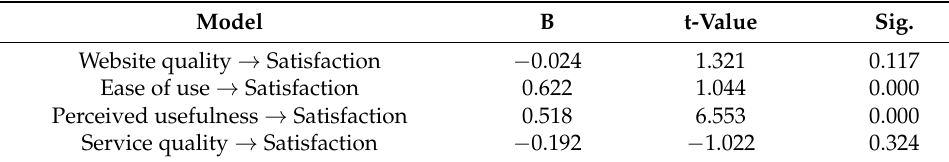
Table 6. Hypothesis testing.